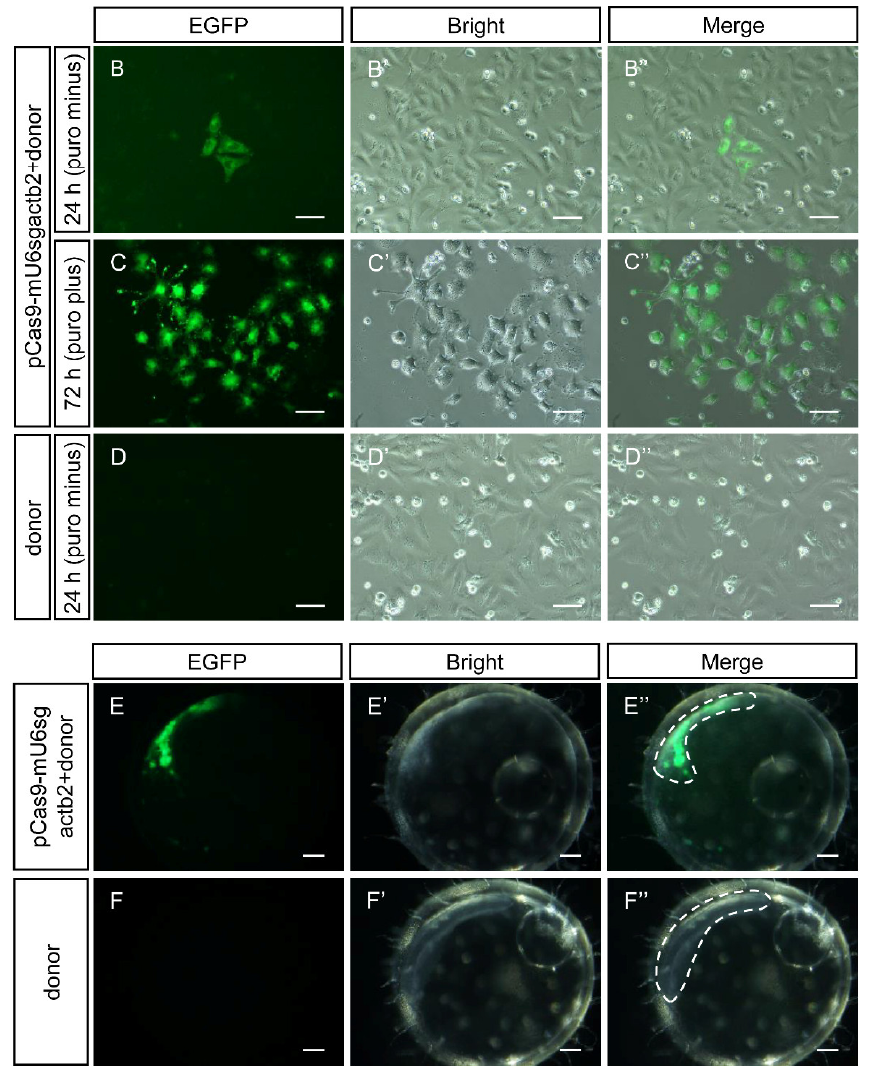
Figure 6. pCas9-mU6sgRNA efficiently mediated the reporter gene puroR-EGFP knock-in in medaka cultured cells and embryos. ( A ) Schematic diagram of gene targeting strategy at medaka actb2 . The donor plasmid containing a promoter-less puroR-EGFP gene was constructed for targeting actb2 . Stop codon is shown in red font. The sgRNA target site is indicated by underline and PAM sequence is indicated in bold. PuroR stands for puromycin resistance gene. A pair of primers used for genotyping are indicated by arrows. The length of the left and right homologous arm are 1232-bp and 1249-bp, respectively. ( B – C (cid:48)(cid:48) ) Representative microscopy images of EGFP + SG3 cells before ( B – B (cid:48)(cid:48) ) and after ( C – C (cid:48)(cid:48) ) 1 mg/mL puromycin selection. ( D – D (cid:48)(cid:48) ) Representative microscopy images of the control cells transfected only with the donor plasmids. Scale bars, 50 µ m. ( E – F (cid:48)(cid:48) ) Microscopy images